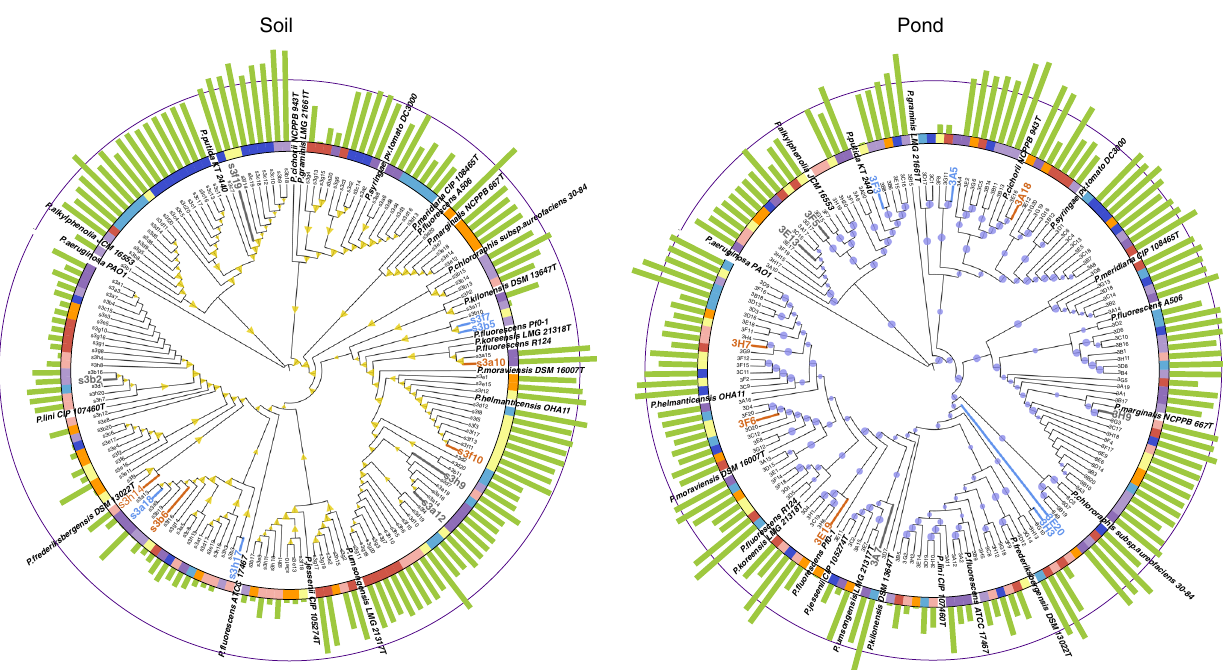
Fig. 2 Maximum-likelihood cladograms for soil and pond isolates based on partial rpoD sequences. For both habitats, P. aeruginosa PAO1 was used as the outgroup, and published rpoD sequences of 20 members of the P. fl uorescens lineage ( strain names in bold ) were integrated into the cladograms to demonstrate phylogenetic af fi liation and diversity of our natural isolates. Yellow triangles and purple circles indicate bootstrap values (50 – 100%) for branches in the soil ( n = 148) and the pond cladogram ( n = 149), respectively. Green bars depict pyoverdine production levels of isolates relative to the laboratory reference strains ( grey ring ). Colour strips around cladograms represent the different communities from which isolates originated. IDs for strains used for pyoverdine cross-feeding and competition assays are enlarged , and the different colours depict pyoverdine non-producers ( light blue font ), producers with a growth-stimulatory pyoverdine ( orange font ) and producers with a non-growth-stimulatory pyoverdine ( grey font